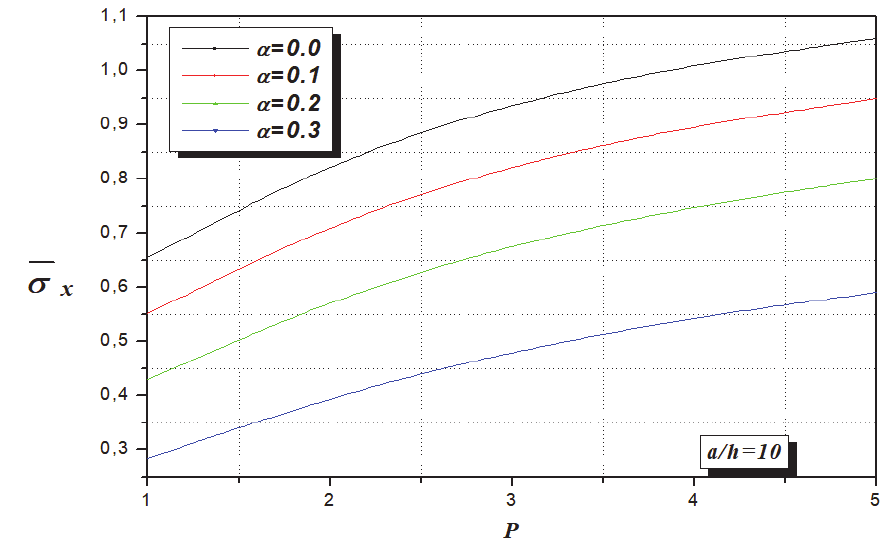
 as a function of the power index P and the different porosity factor α of sandwich x